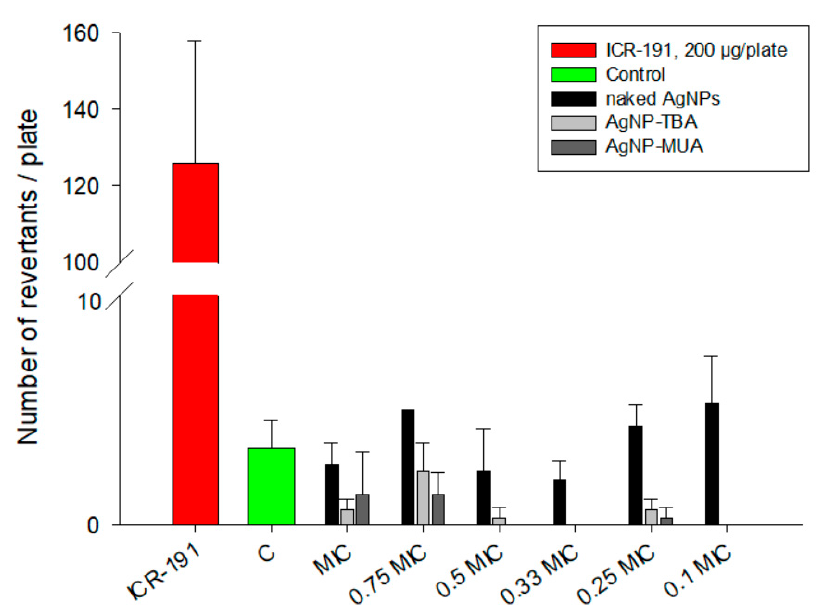
Figure 8. Mutagenic activity of different AgNPs in S. typhimurium TA98 mutagenicity test: 200 μ g/plate of ICR-191 was used as a positive control (red column). C—negative control, bacteria incubated with water. Purple columns represent bacteria incubated with naked AgNPs in a 0.09–0.9 μ g/mL concentration range. Light blue columns represent bacteria incubated with AgNP-TBA in a 0.078–0.78 μ g/mL concentration range. Navy blue columns represent bacteria incubated with AgNP-MUA in a 0.066–0.66 μ g/mL concentration range. Results are reported as mean number of revertants ±SD. MIC—minimum inhibitory concentration.